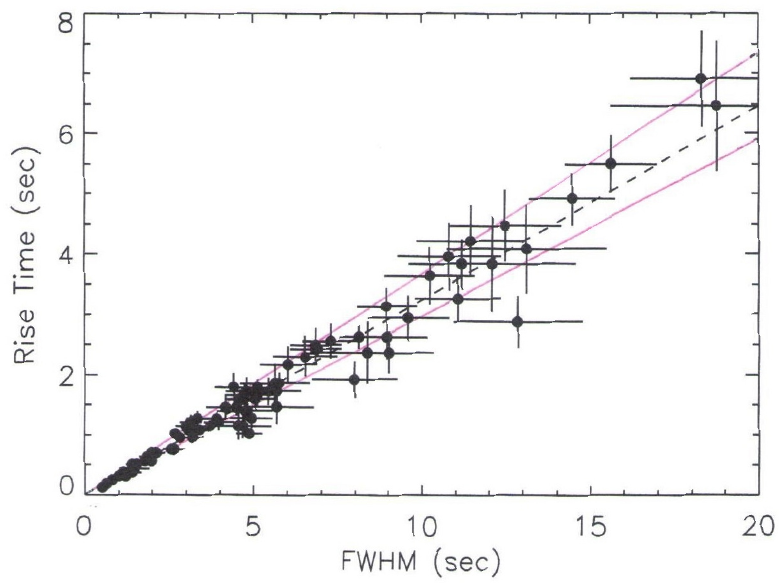
Figure 8. Comparison between the rise time RT versus the FWHM reported in [80] for a sam- ple of 77 resolved pulses measured with BATSE aboard CGRO. The dotted line is best fit ratio RT/FWHM = 0.32 and the solid lines are CB model expected boundaries 0.29 < RT/FWHM < 0.36 for LGRBs.